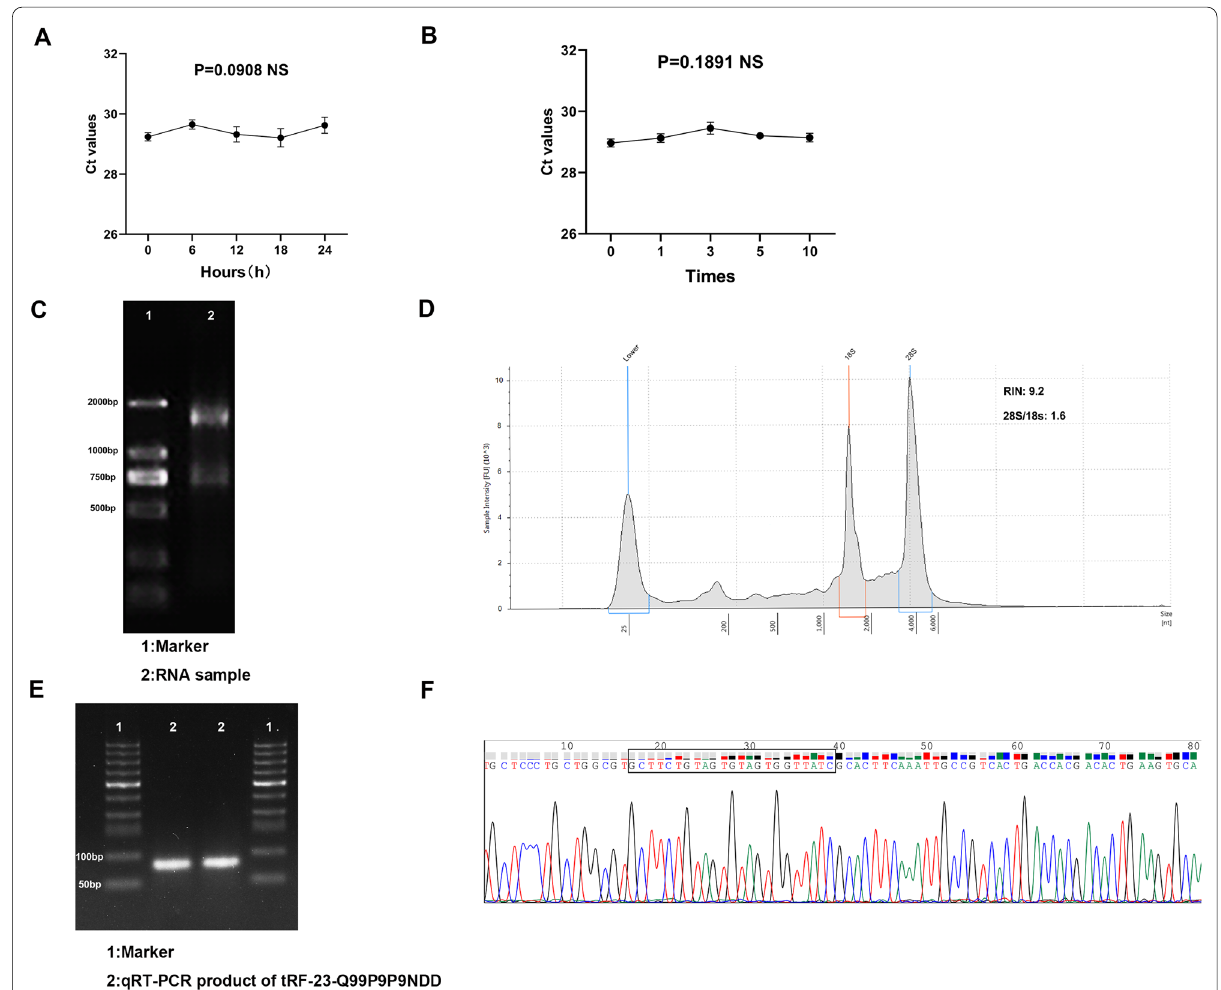
Fig. 2 Methodological evaluation of tRF-23-Q99P9P9NDD. A , B Room temperature placements and repeated freeze–thaw experiments showed no significant changes in the expression level of tRF-23-Q99P9P9NDD. C Evaluation of RNA sample integrity by agarose gel electrophoresis. D Evaluation of RNA sample integrity by RIN evaluation. E The product of qRT-PCR was electrophoresed on 2% agarose gel, and a single band of about 80 bp was obtained. F Sanger sequencing of the qRT-PCR product confirmed that the product contained the full-length sequence of